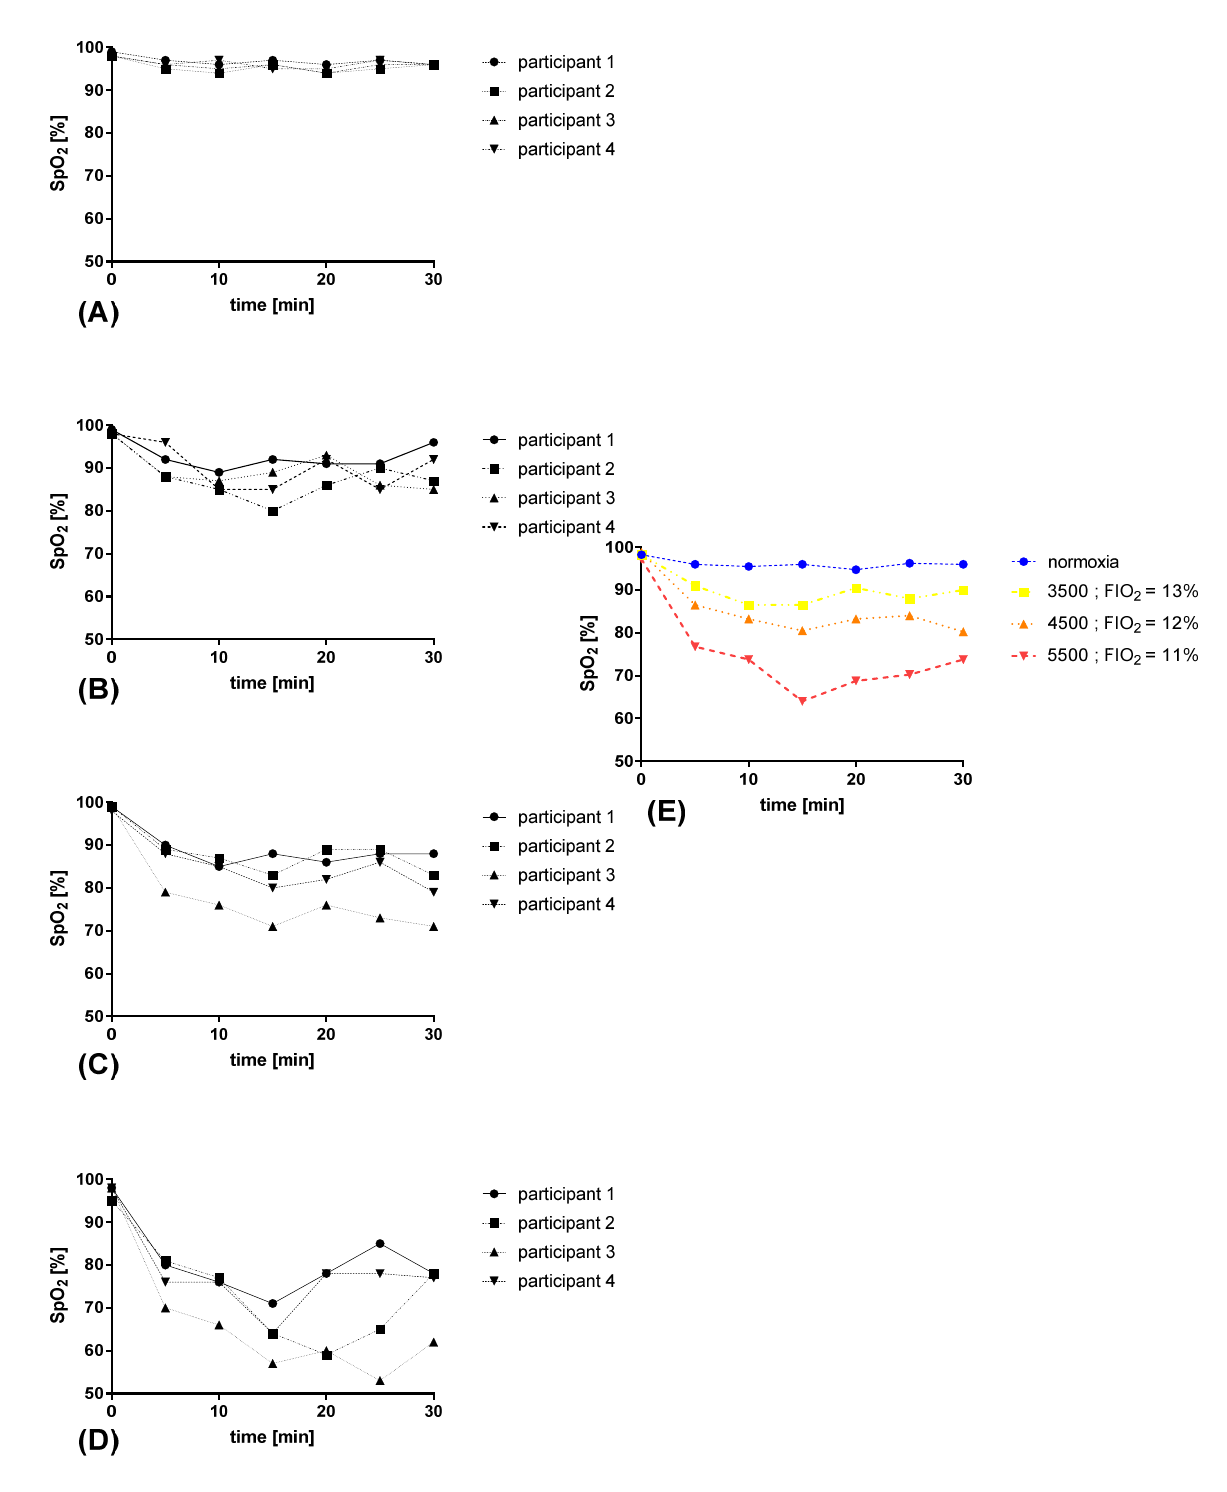
Figure 3. Effect of acute normobaric hypoxia exposure at various simulated altitudes (a.s.l.) on blood saturation: ( A ) saturation under normoxia; ( B – D ) saturation at FIO 2 = 13%, FIO 2 = 12%, and FIO 2 = 11%, respectively; ( E ) mean values at various simulated altitudes.